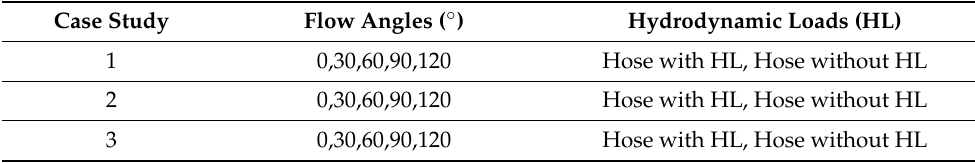
Table 9. Definition of Case Study for the 3 Environmental Cases.